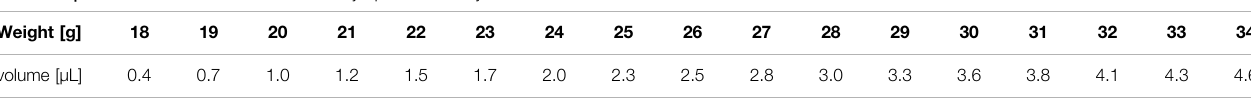
TABLE 1 | Recommended volumes for olfactory-speci fi c delivery in C57Bl6